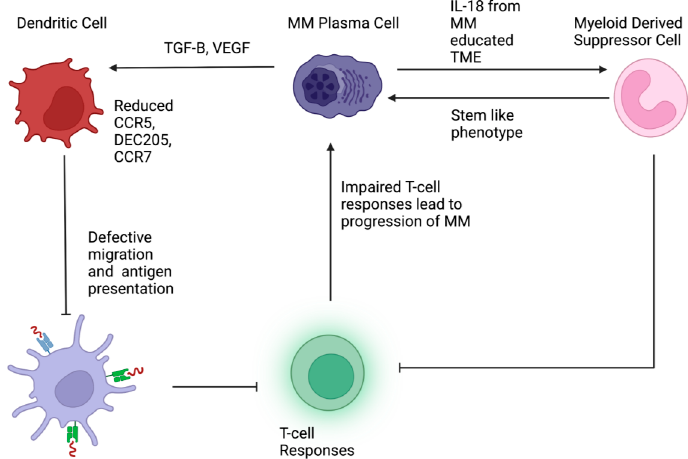
Figure 2. Interaction between multiple myeloma (MM) cells, dendritic cells (DC), and myeloid de- rived suppressor cells (MDSC). MM cells produce cytokines and growth factors, which lead to im- paired differentiation, migration, and antigen presentation by DCs. Dysfunctional DCs lead to de- fective T cell activation. Overproduction of interleukin 18 (IL-18) in the MM tumor microenviron- ment drives MDSCS, which in turn suppress T cell responses. MDSCS also confer stem-like proper- ties to MM cells increasing their proliferative capacity. 7. High-Dimensional Profiling of TAMs and Related Myelomonocytic Cells in Cancer The majority of studies evaluating TAMs in MM have relied on IHC or flow cytom- etry with a limited marker panel to identify and describe TAMs. These studies also pre- dominantly used a binary classification of M1 (anti-tumor) as opposed to M2 (pro-tumor) phenotypes. The last decade has brought about a rapid escalation in our knowledge of macrophage biology, especially concerning their ontogeny, heterogeneity, and plasticity [10,98]. The M1 vs. M2 classification is hence likely to be too simplistic to adequately un- derstand TAMs, and more sophisticated techniques are needed to provide more granular insight into the phenotype of the various TAM subsets. As discussed above, MDSCs and DCs are also highly heterogeneous in phenotype and function and may not be adequately characterized by conventional techniques. A multiparametric approach is required to evaluate complex populations, such as myelomonocytic cells in the TME. At the protein level, cytometry by time-of-flight mass spectrometry (CyTOF) has emerged as a powerful technique allowing the simultaneous evaluation of up to 40 cell surface or cytoplasmic markers [99]. CyTOF has been success- fully applied to study TAMs in lung and brain malignancies [16] among others. Spectral flow cytometry has also shown potential as a tool for high-dimensional immune profiling, overcoming the limitations of spectral overlap associated with conventional flow cytom- etry [100]. Single-cell RNA sequencing (scRNAseq) has great value as a tool to unravel tumor microenvironmental heterogeneity [16]. Indeed, scRNAseq has been applied to